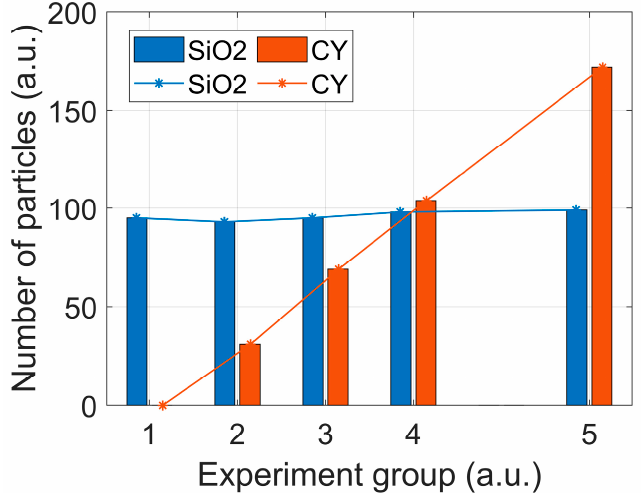
Figure 8. Group bar plot for particle number of SiO 2 and CY. Groups 1~5 corresponds to mixtures with total volumes of CY concentrate, 0, 50, 100, 150, and 250 μ L, respectively.